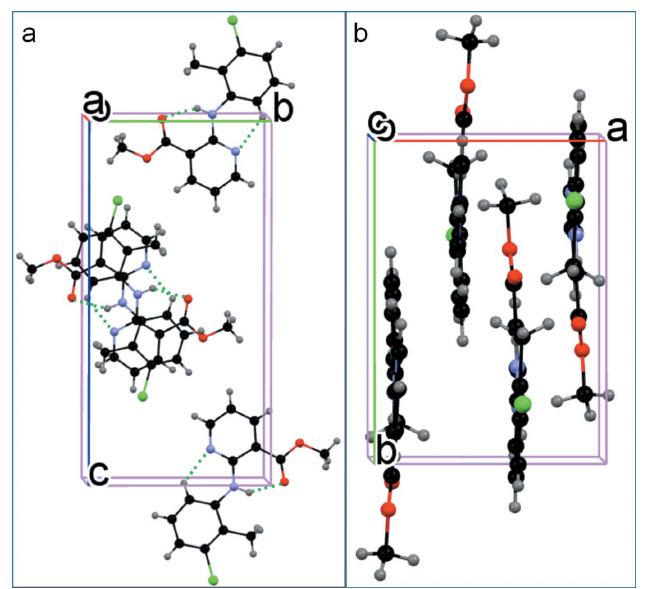
Figure 2 ( a ) Packing of the molecules in the title compound viewed along [100] with the intramolecular hydrogen bonds indicated by green dashed lines; ( b ) packing of the molecules in the title compound viewed along [001].